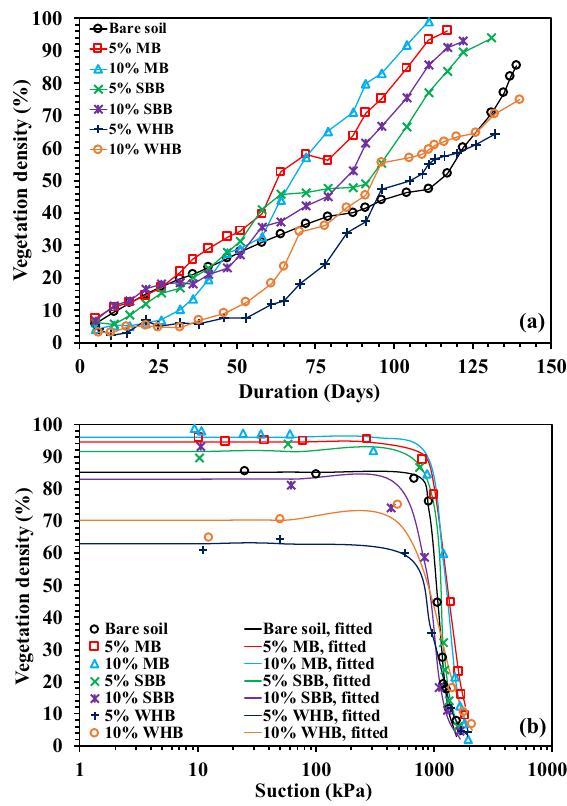
Figure 7. Variation of vegetation density with ( a ) time and ( b ) suction in different